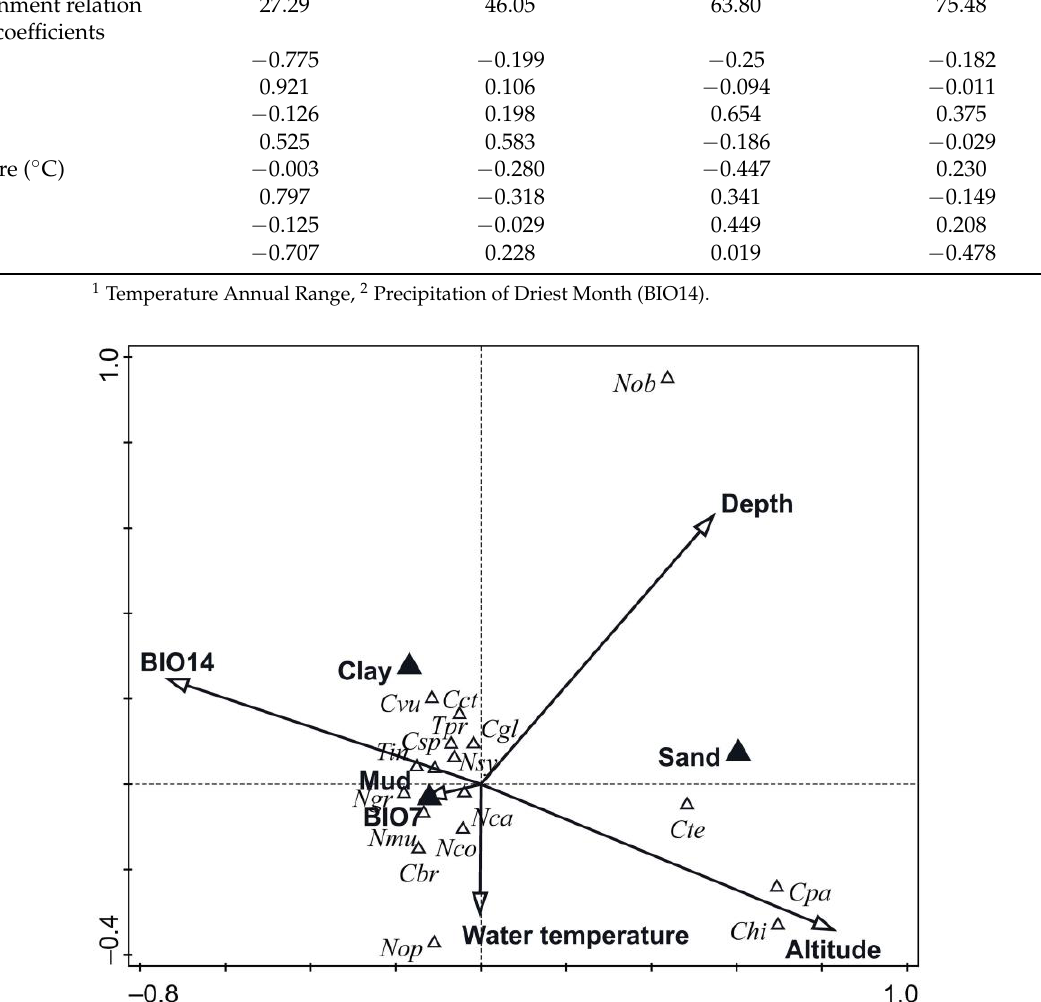
Table 1. Results of canonical correspondence analysis of charophyte presence in relation to environ- mental variables.